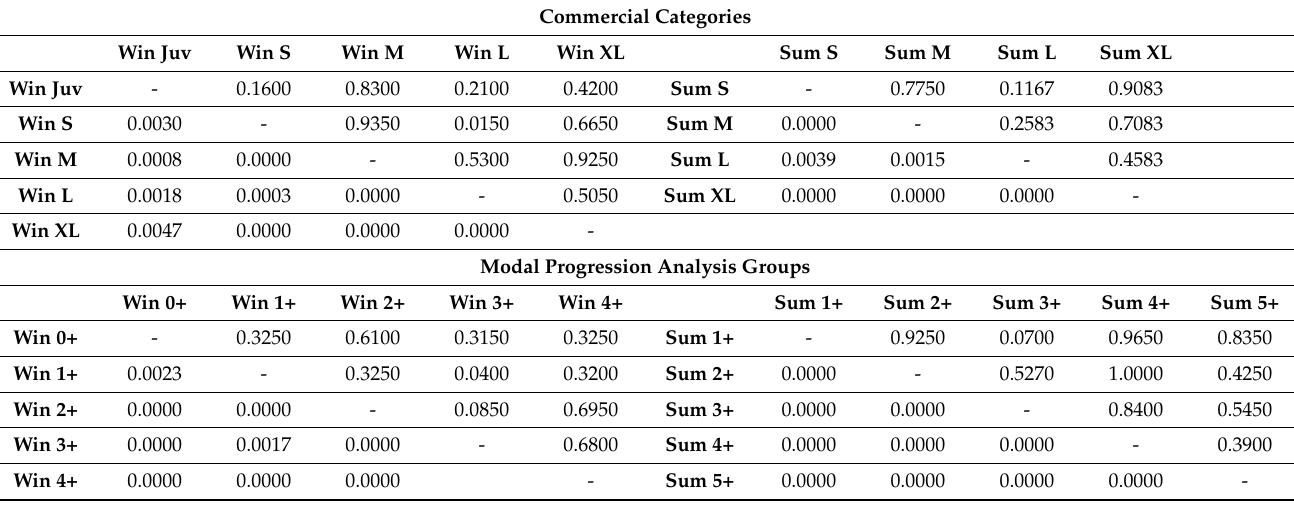
Table 4. Pairwise F ST among A. antennatus female groups (below diagonal) and p -values (above